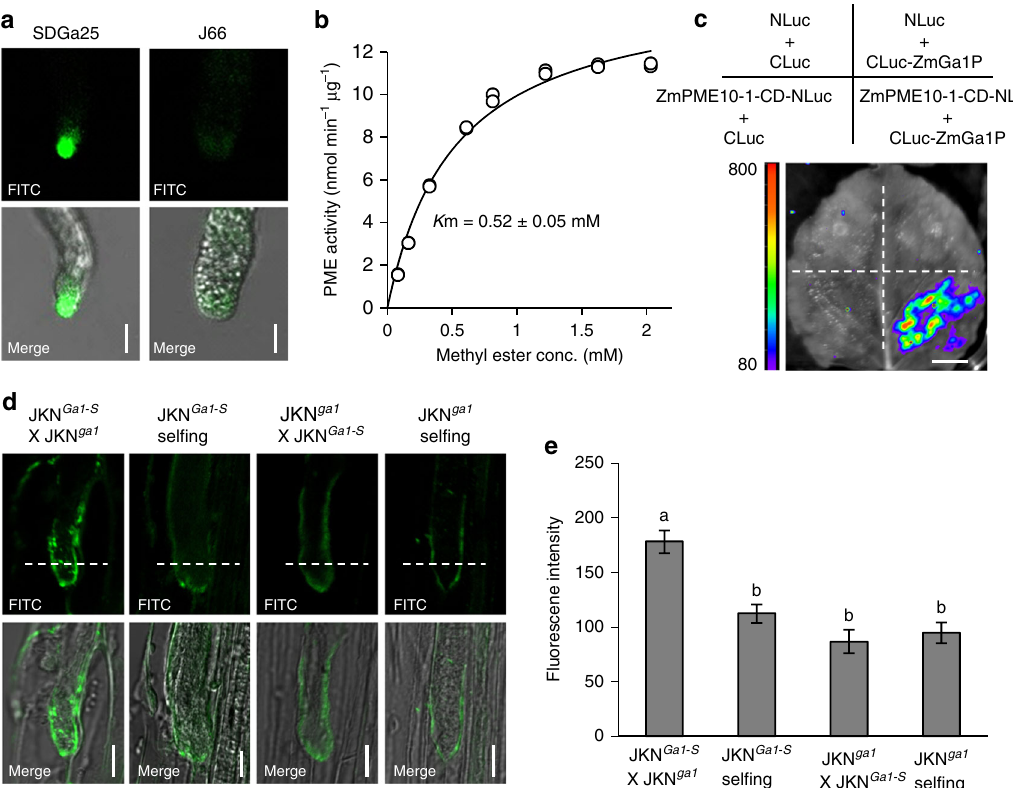
Fig. 3 Characterization of ZmGa1P biochemical properties. a Immuno-staining the pollen tubes of SDGa25 ( Ga1-S ) and J66 ( ga1 ) using the anti-ZmGa1P antibody. Scale bar = 10 μ m. b Kinetic analysis of PME activity of secretory proteins in the fraction 8 of SDGa25. Error bars represent the mean ± SD of three replicates. c Split-luciferase complementation assay showing the interaction between ZmGa1P and the PME domain (CD) of ZmPME10-1 in N. benthamiana leaves in fi ltrated with the construct combinations shown above. Scale bar = 1 cm. d Immuno-detecting highly methylesteri fi ed pectins in the longitudinally sectioned pollen tubes of near isogenic lines with LM20 antibody. Scale bars = 10 μ m. FITC, Fluorescein isothiocyanate. e Quanti fi cation of the fl uorescent signal intensity of immune-examinations, to show the varied pectin DM on ga1 pollen tube walls growing in Ga1-S silks. Error bars represent the mean ± SE ( n > 15 pollen tubes). a and b indicate that the means differ according to analysis of variance and Tukey ’ s test ( P < (Supplementary Fig. 15c). Application of the split-luciferase complementary assay in the transiently transformed tobacco leaves further corroborated the interaction between ZmGa1P and the PME domain or signal peptide-depleted version of ZmPME10-1 (Fig. 3c and Supplementary Fig. 15d).